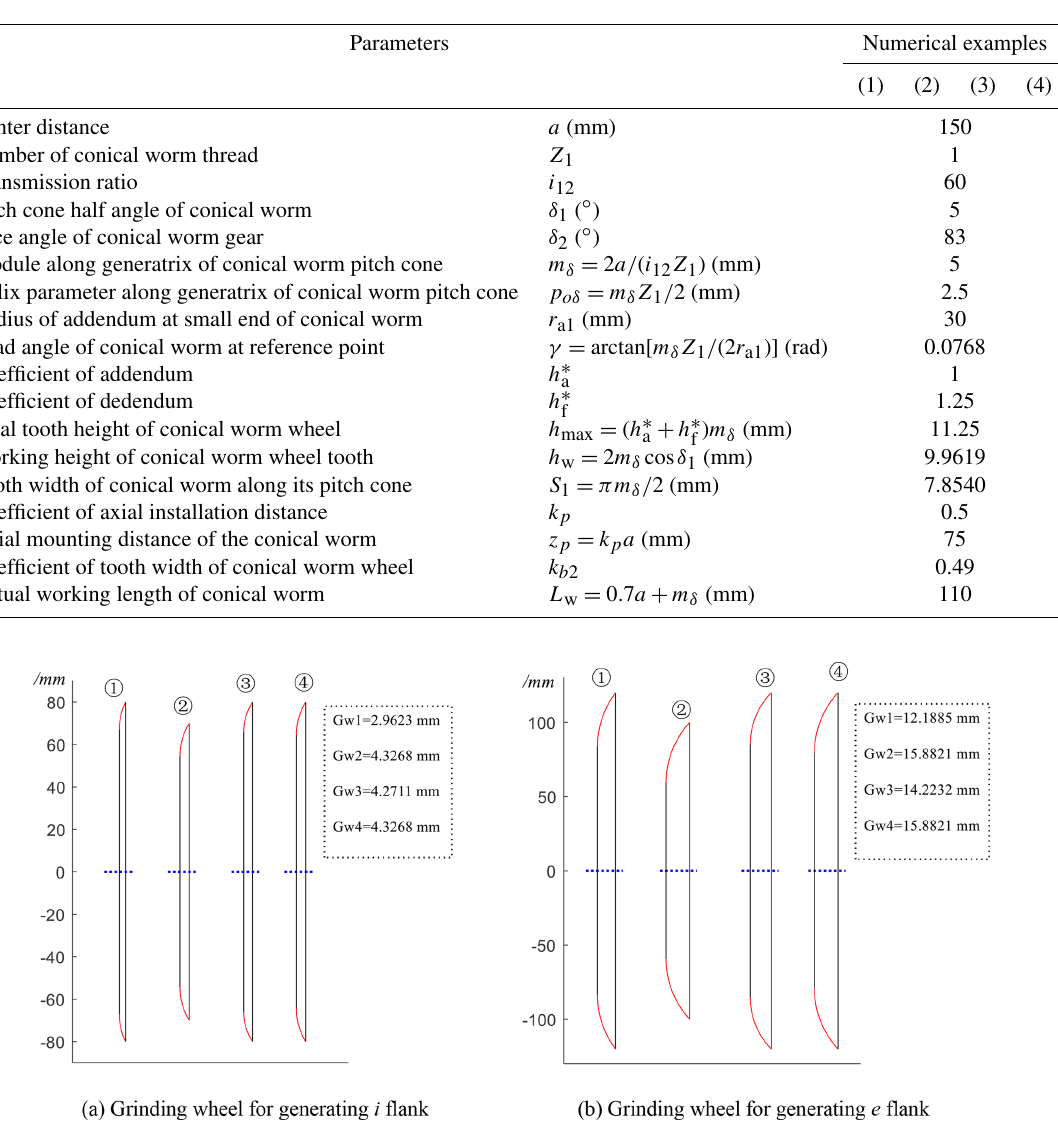
Table 1. Parameters of the conical worm drive in each numerical example.